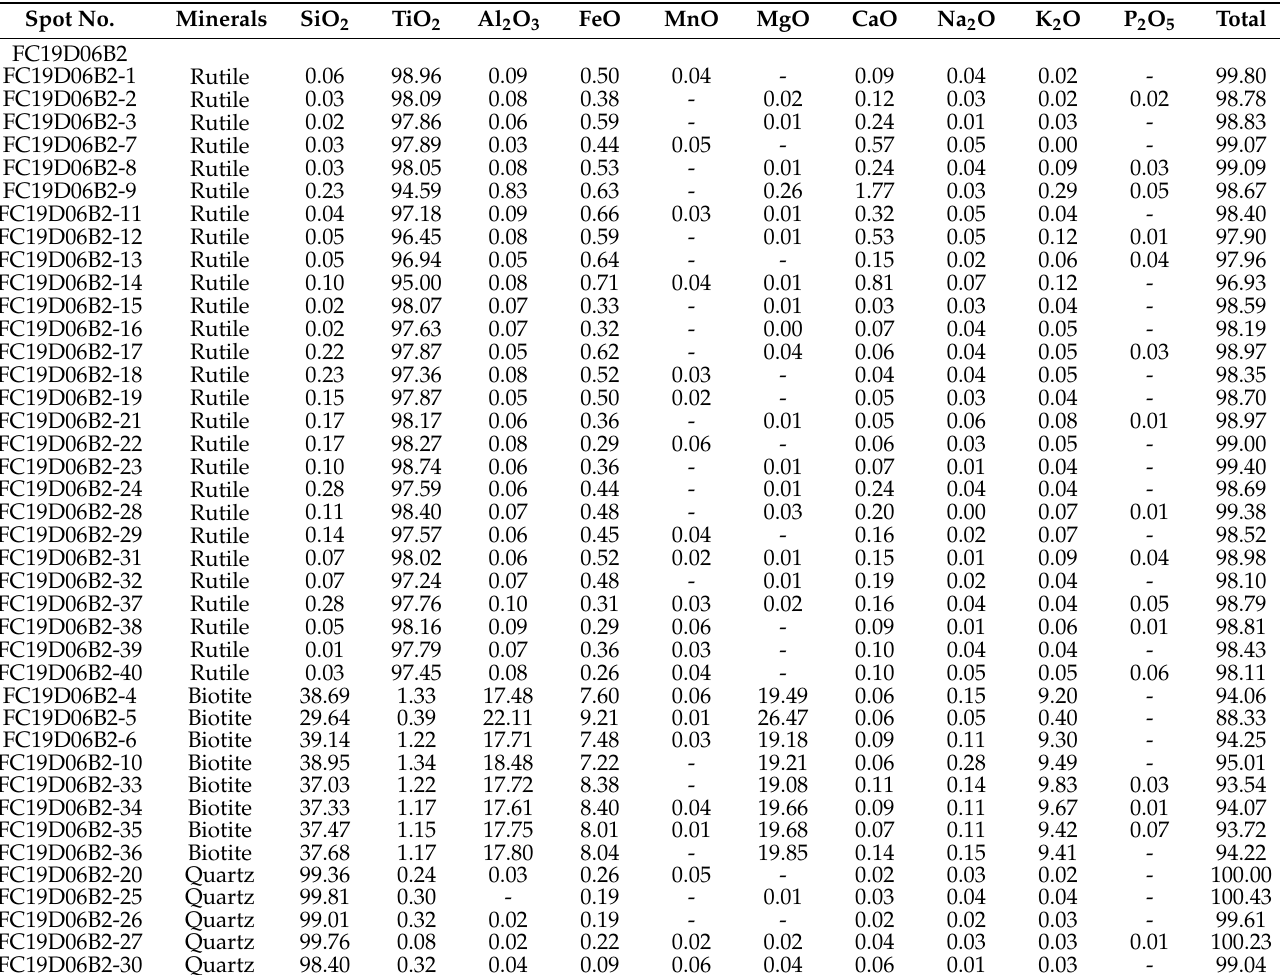
Table 1. Electron microprobe analysis (EMPA) of the major elements (wt%) in rutile, biotite, and quartz. Spot